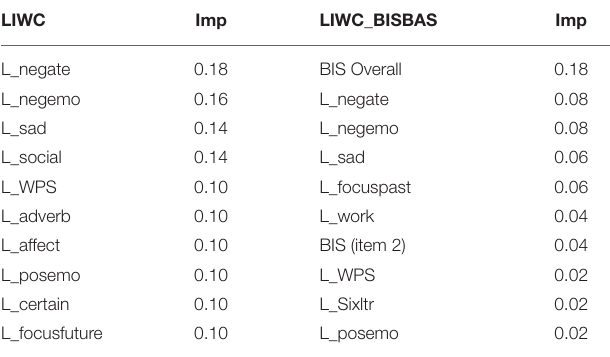
TABLE 3 | Permutation-based feature importance (Imp) for Generalized Anxiety Disorder (GAD) classification for the Random Forest (RF) model for Language Inventory Word Count (LIWC) categories and for the concatenation of LIWC categories with Behavioral Inhibition System and Behavioral Approach System features